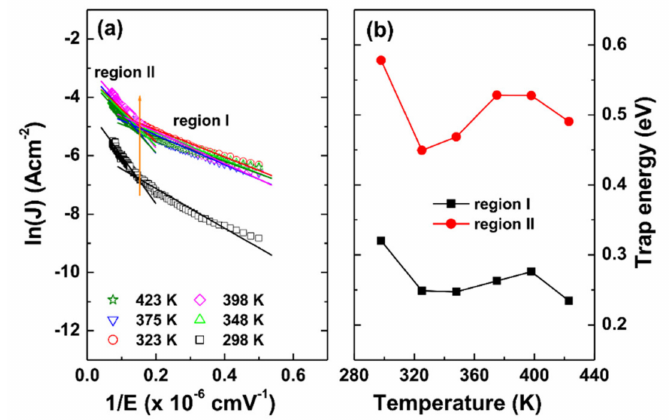
Figure 6. ( a ) Trap assisted tunneling (TAT) plots of ln( J ) vs. 1 / E and ( b ) the obtained trap energy for sample